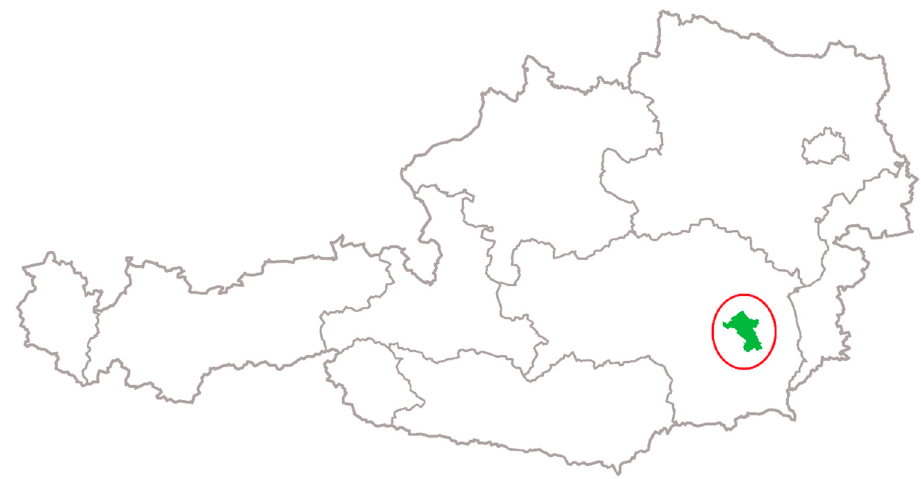
Figure 1. Map of Energy Region Weiz-Gleisdorf ′ s (EWG ′ s) location in Austria (red circle). Source: [51].